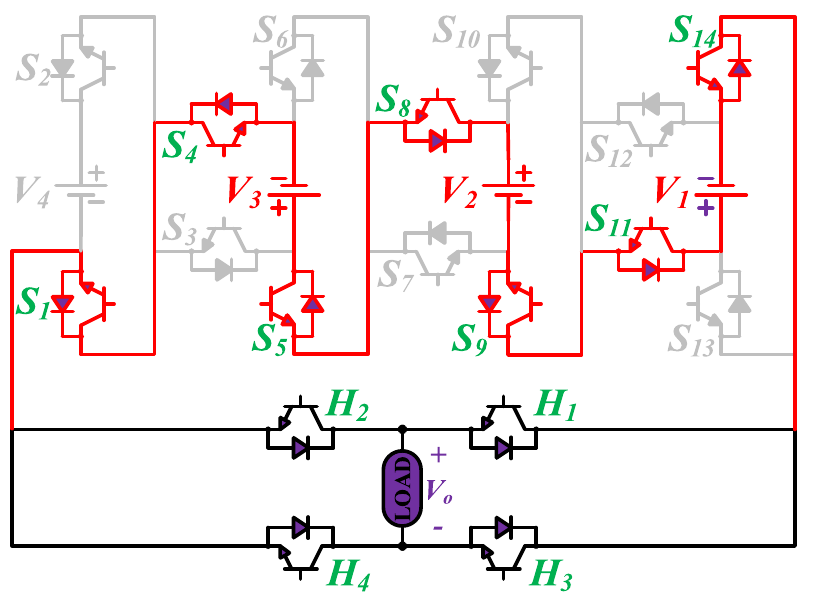
Fig 5. Switching states for voltage magnitude level 5.